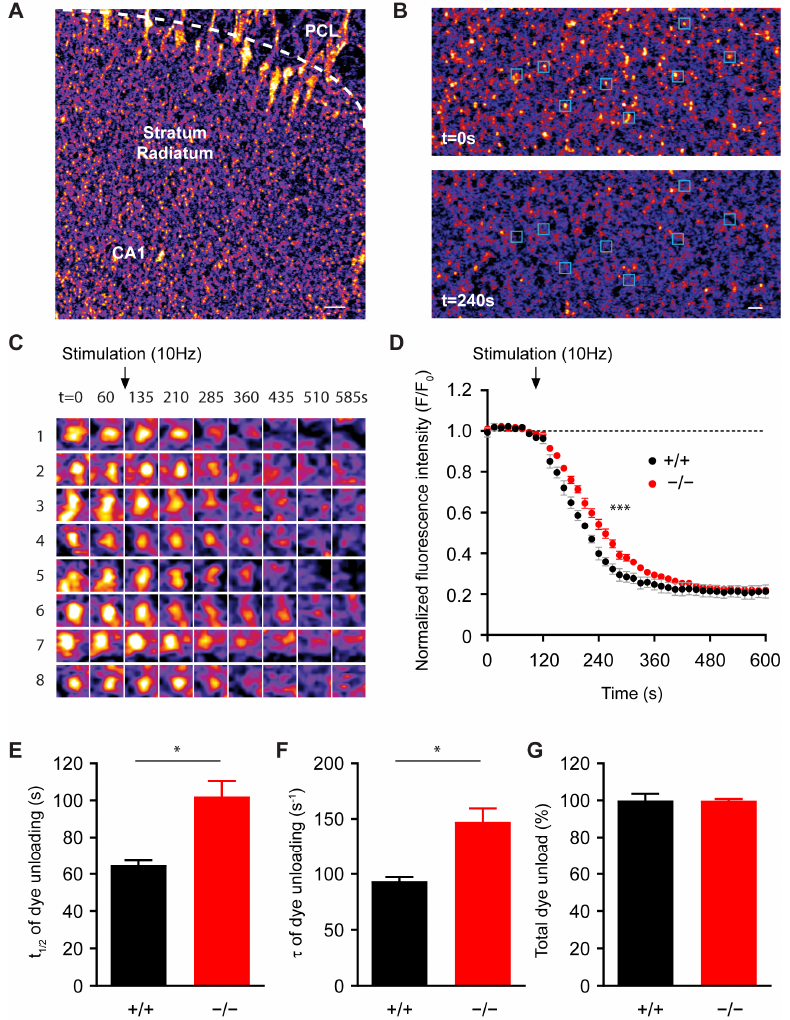
Figure 5. Astroglial Cx43 contributes to synaptic vesicle recycling in hippocampal neurons. ( A ) Representative image of the CA1 stratum radiatum region of a hippocampal slice that is loaded with FM1-43 in presynaptic terminals, as is shown in the fl uorescently labeled punctate structures. ( B ) The dye-loaded regions are shown at a higher magni fi cation both before (t = 0) and after (t = 240 s) the dye unloading induced by the 10 Hz stimulation for 2 min. Blue squares mark eight individual synaptic puncta, thereby showing an unloading of FM1-43 dye upon stimulation. ( C ) Time series images of dye unloading are shown for each synaptic puncta marked in ( B ). ( D ) Normalized fl uorescence intensity is plo tt ed over time showing the unloading of FM1-43 dye upon stimulation, which is signi fi cantly slower in hippocampal slices from Cx43 − / − ( − / − ) mice when compared to wild-type (+/+) ( E – G ) The plots showing the average of half time (t 1/2 , E ) and decay time constant ( τ , F ) of dye unloading, which was found to be signi fi cantly higher in − / − when compared to +/+, while, the relative total dye unloaded ( G ) was not di ff erent. Mean ± SEM; n = 3 (+/+) and 4 ( − / − ) independent experiments; * p < 0.05; *** p < 0.001; and scale bar: 50 µm in ( A ) and 20 µm in ( B ).